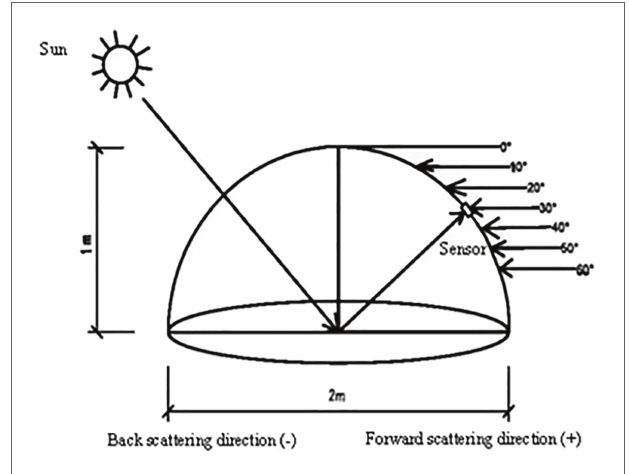
FIGURE 1 | Dimensions and design of the field goniometer